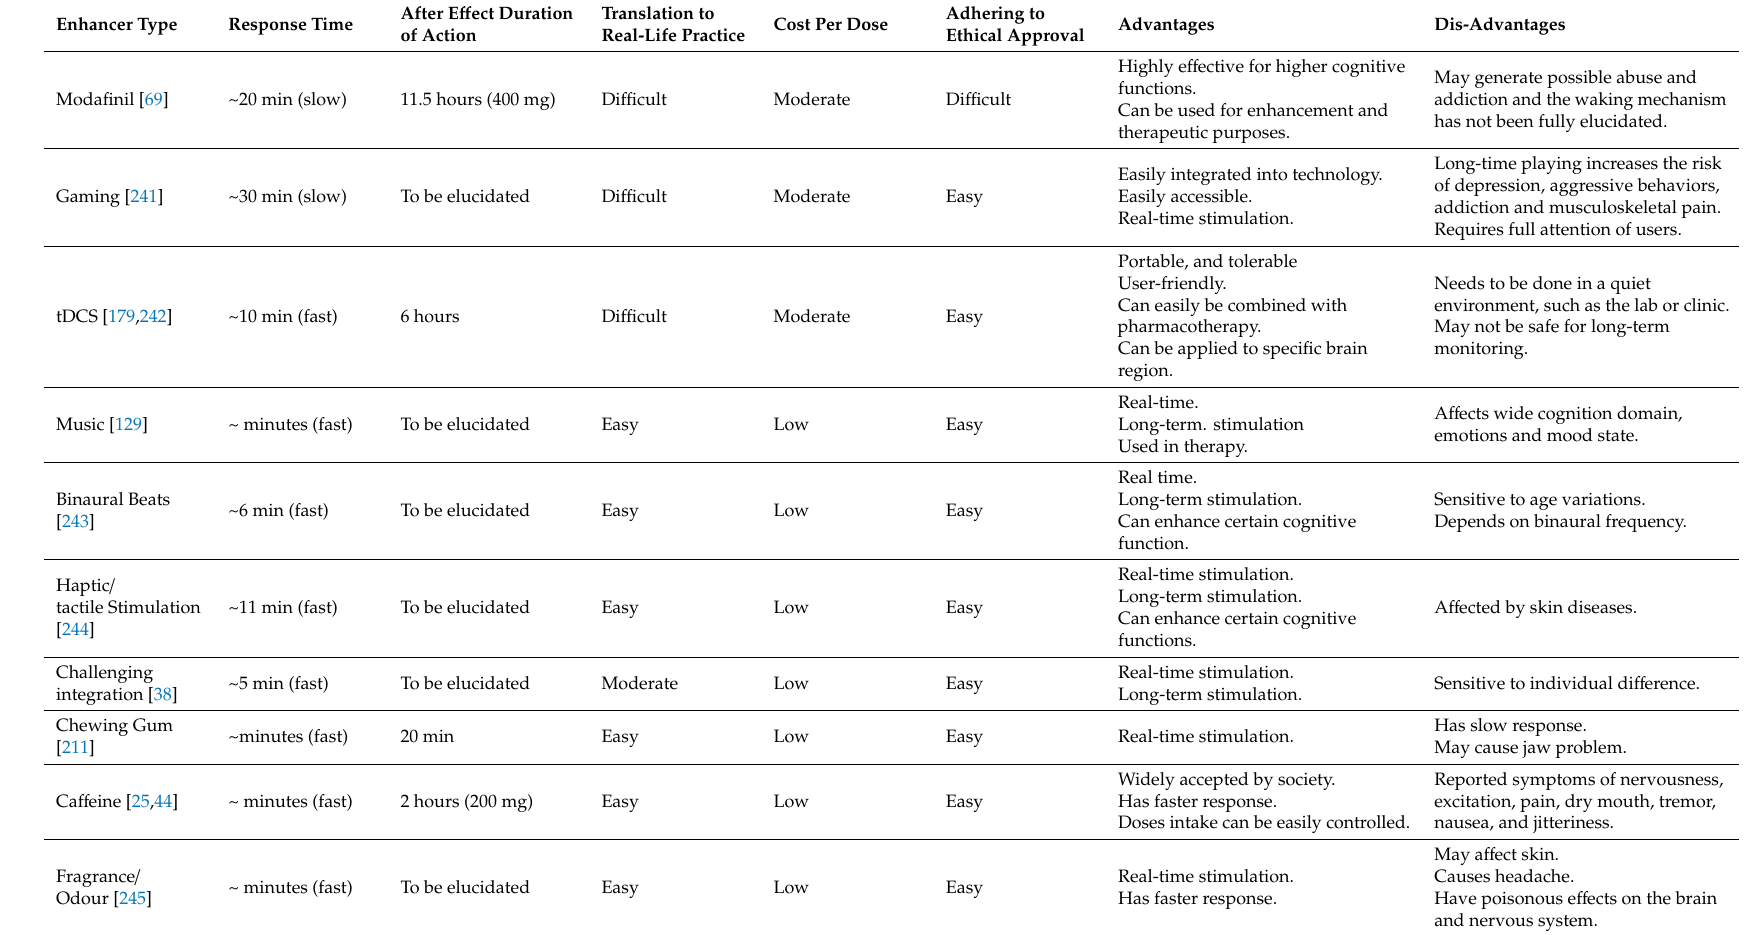
Table 2. Comparison of enhancement